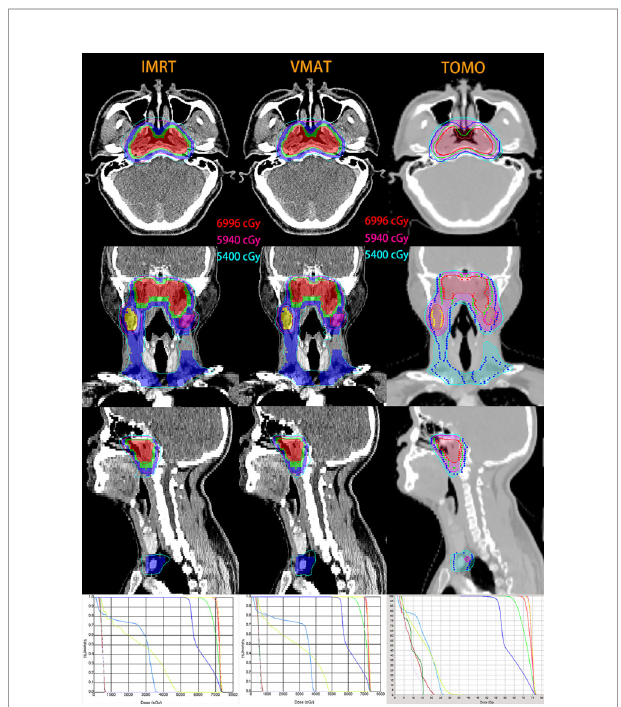
FIGURE 1 | Isodose distributions and dose-volume histograms (DVHs) for a representative T 1 -stage NPC patient with IMRT (left), VMAT (middle) and TOMO (right) planning. Maroon, forest, lavender, yellow-green, light-blue, red, green and blue lines in three DVH are optic nerve in left, optic nerve in right, optic chiasma, brain stem, spinal cord, PGTVnx, PCTV-1 and PCTV-2, respectively. For IMRT and VMAT planning, color-wash areas: PGTVnx (red), PGTVnd-left (purple), PGTVnd-right (yellow), PCTV-1 (green), PCTV-2 (blue); and the red, purple and sky-blue lines are isodose curves of 69.96Gy, 59.4Gy and 54Gy. For TOMO planning, isodose curves of 69.96Gy, 59.4Gy and 54Gy are shaded in the red, purple and sky-blue, respectively; targets are represented by lines: PGTVnx (red), PGTVnd-left (purple), PGTVnd-right (yellow), CTV-1 (green), PCTV-2